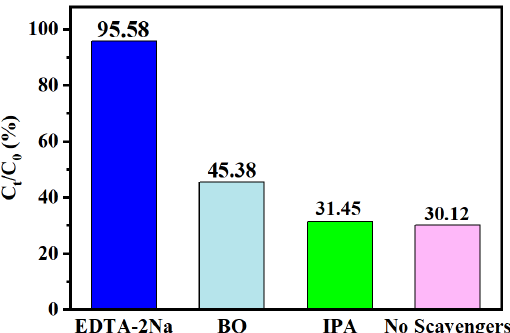
is not a critical reactant.